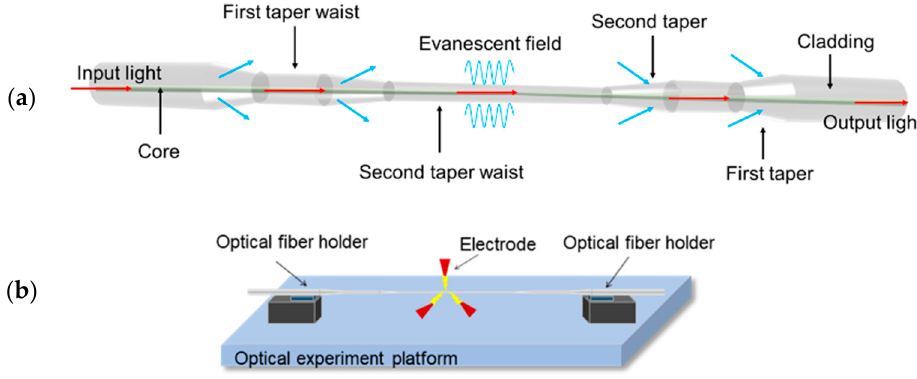
Figure 1. ( a ) Schematic structure of the taper-in-taper fiber sensor; ( b ) The tapering